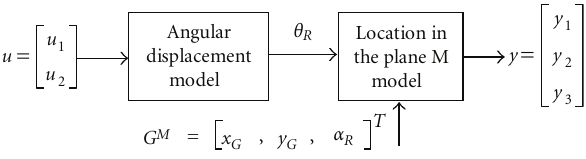
Figure 12: Block diagram of the model.